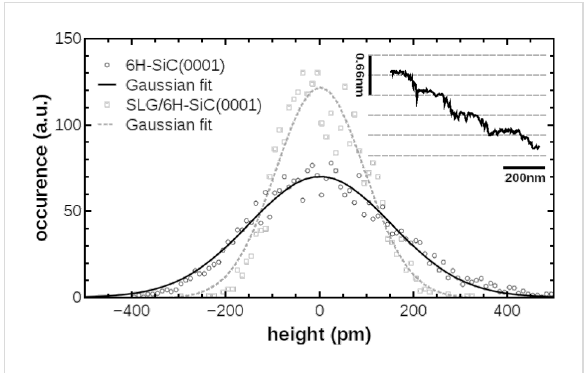
Figure 2: Roughness analysis of NC-AFM images taken on a single terrace within 70 × 70 nm 2 on the 6H-SiC(0001) substrate (standard deviation σ = 304 pm) and on the SLG ( σ = 189 pm). The inset shows a line profile taken on the SLG flake perpendicular to substrate step edges measured by Kelvin-compensated NC-AFM.